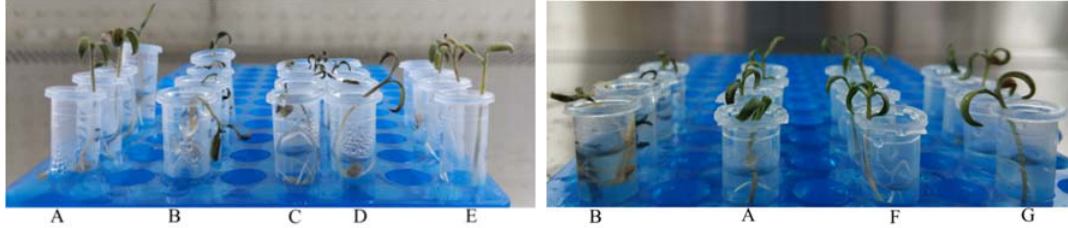
Figure 4. Control e ffi ciency of strain NEAU-HV9 against R. solanacearum . A, tomato seedlings were inoculated with sterile water (CK 1); B, tomato seedlings only were inoculated with R. solanacearum (CK 2); C, tomato seedlings were pre-inoculated with suspension (10 7 cfu mL − 1 ) of NEAU-HV9 and then inoculated with R. solanacearum (TR 1); D, tomato seedlings were pre-inoculated with suspension (10 8 cfu mL − 1 ) of NEAU-HV9 and then inoculated with R. solanacearum (TR 1); E, tomato seedlings were pre-inoculated with suspension (10 9 cfu mL − 1 ) of NEAU-HV9 and then inoculated with R. solanacearum (TR 1); F, actinomycin D at the concentration 1 × MIC (TR 2); G, actinomycin D at the concentration 2 × MIC (TR 2). Table 3. E ff ect of the strain NEAU-HV9 and actinomycin D on the incidence and control of tomato bacterial wilt in tomato seedlings.